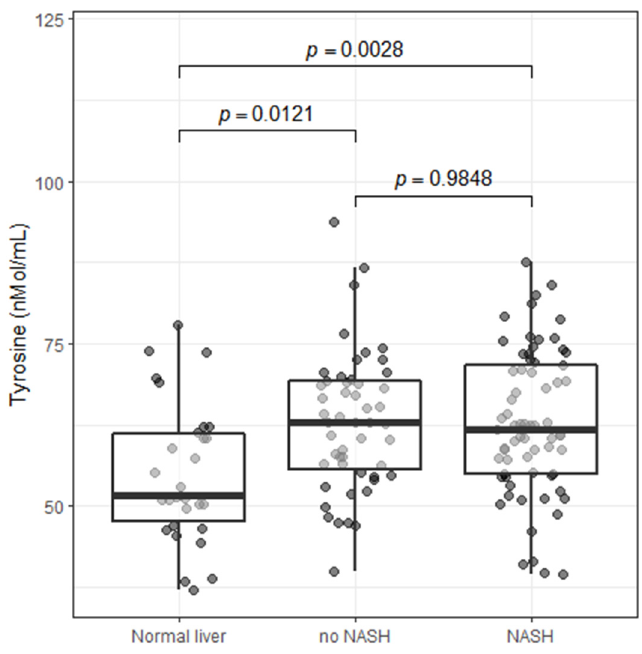
Figure 3. Observational analysis of the impact of NAFLD and NASH on tyrosine levels in the IUCPQ Obesity Biobank. Box plot representing the dispersion and the median values of tyrosine levels between the three groups (without NAFLD = 54.9 ± 10.7 nmol/mL; with NAFLD–without NASH = 62.5 ± 10.9 nmol/mL; with NAFLD and NASH = 62.9 ± 11.0 nmol/mL). p -values are from Tukey HSD test.